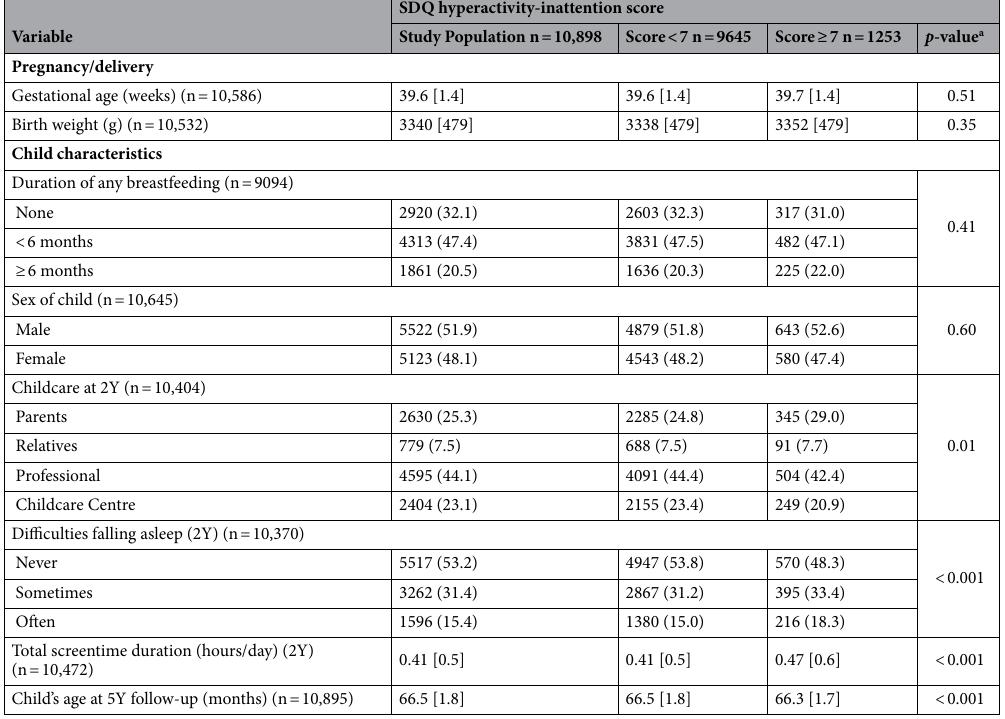
Table 1. Descriptive characteristics of the overall population (N [%] or mean [STD]) by SDQ hyperactivity- inattention score in the ELFE study (n = 10,898). a Difference by hyperactivity-inattention score, by ANOVA or by chi 2 test. BMI body mass